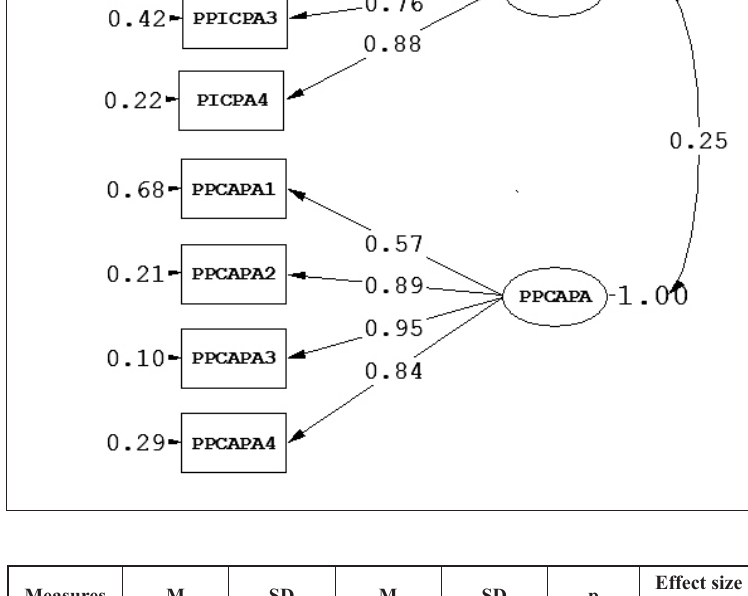
Table. Mean values of perceived